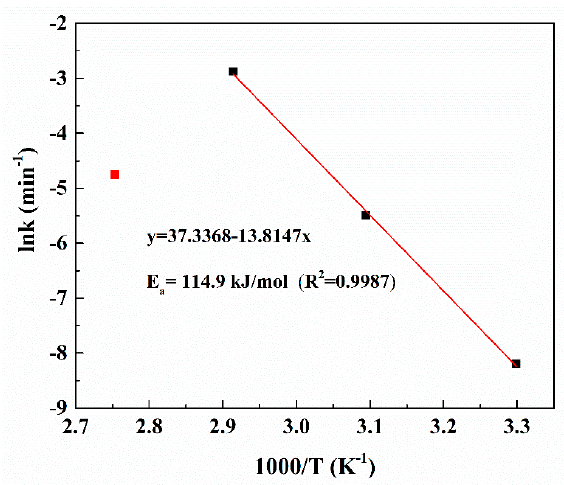
Figure 10. Arrhenius plot for leaching of Pt in the temperature range of 303.15–363.15 K.